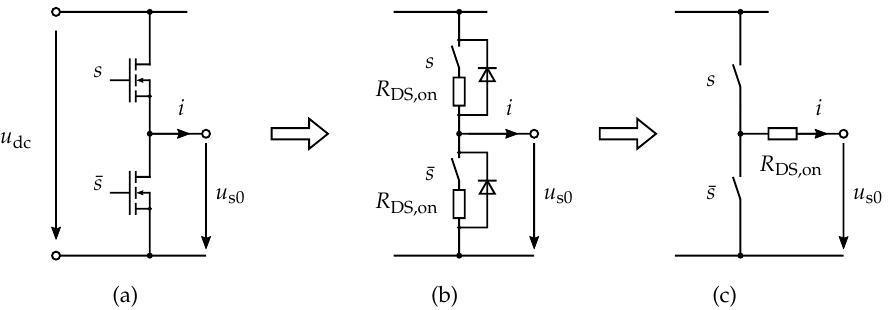
Figure 2. One half-bridge of the voltage source inverter with ( a ) the two MOSFETs, ( b ) the equivalent circuit of the MOSFETs and ( c ) the simplification of the half